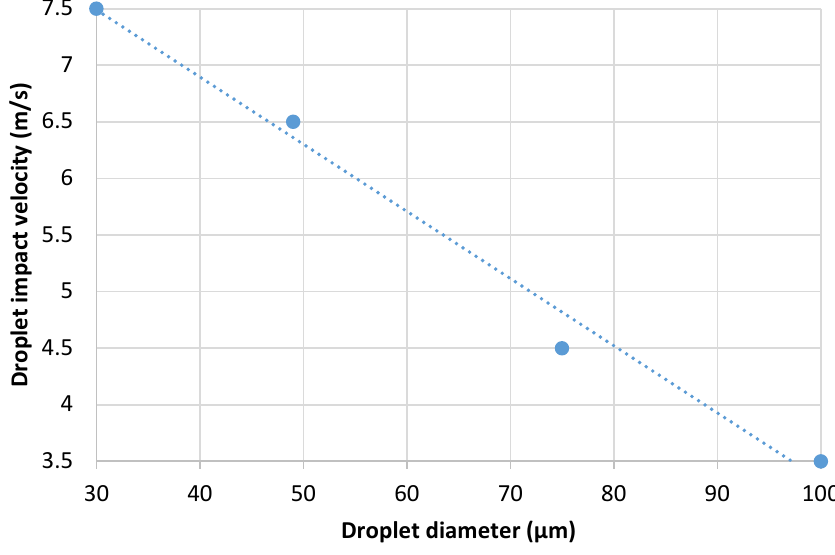
Figure 7. Minimum impact velocity to achieve droplet rebound as a function of droplet diameter.